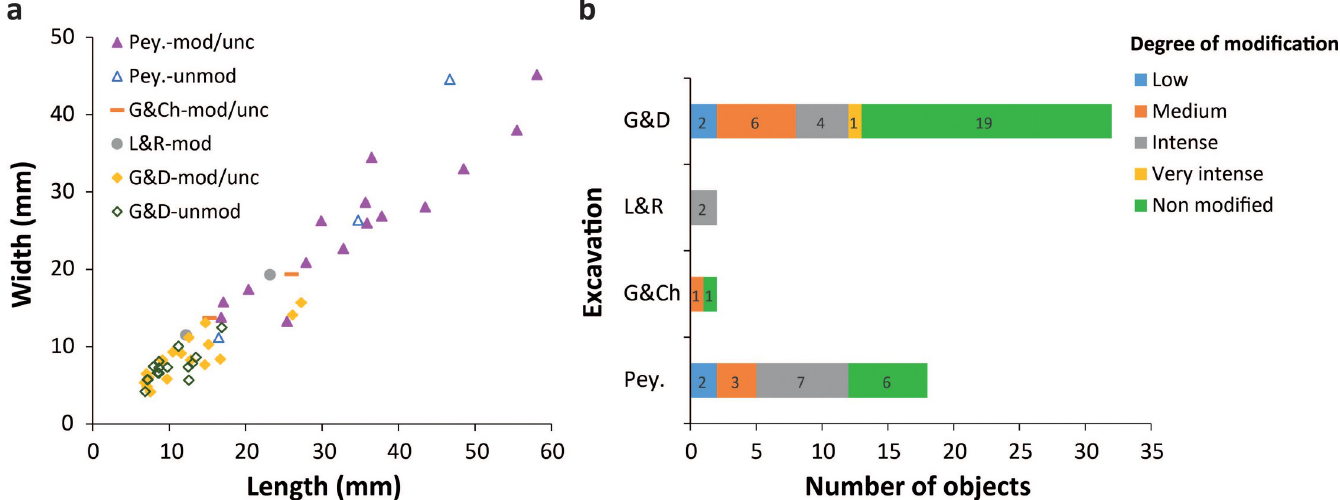
Fig 2. Taphonomic analysis of the manganese-rich rocks. Difference in size (a) and degree of modification (b) of manganese lumps from Le Moustier excavations.